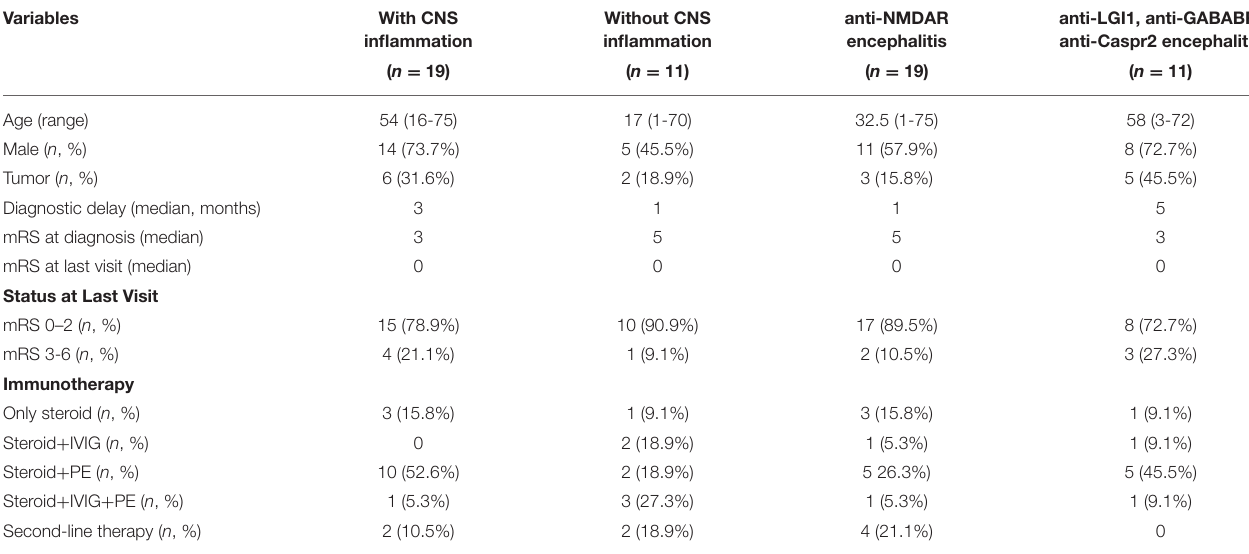
TABLE 2 | Comparison of AE patients regarding the presence of CNS inflammation and associated autoantibody type. Variables With CNS